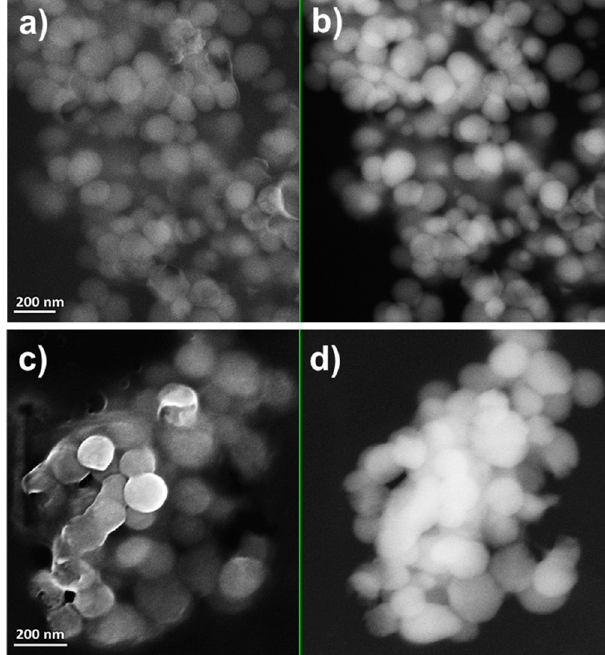
Figure 3. Scanning electron micrographs of ( a , b ) SeNPs MPV1-2_48_e and ( c , d ) SeNPs MPV1-2_120_e recovered from MPV1 cells grown for 48 h: ( a ) InLens detector and ( b ) backscattered electron detector, or 120 h: ( c ) InLens detector and ( d ) backscattered electron detector in the presence of 2 mM SeO 3 2 − .